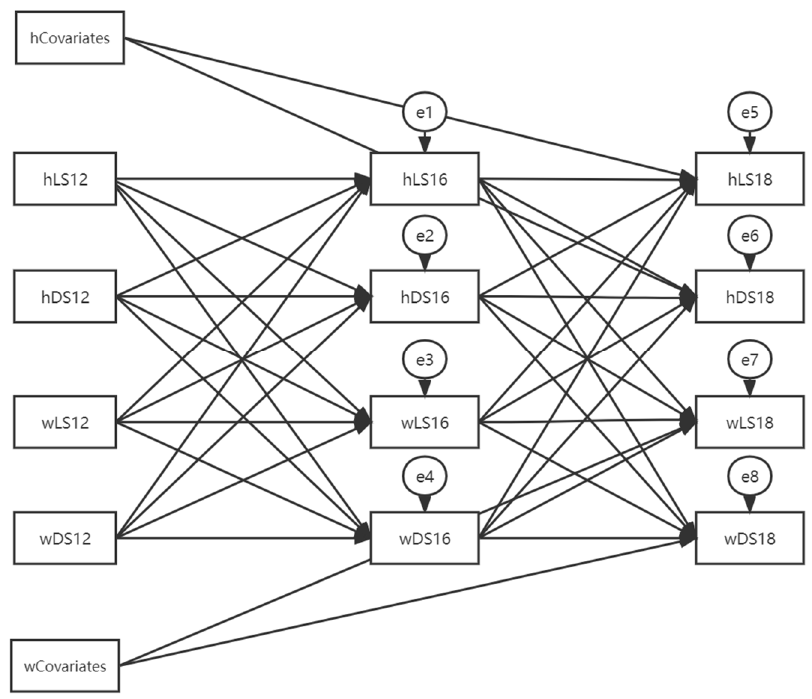
Figure 3. The full APIM model. Note: w, wives’; h, husbands’; MS, marital satisfaction; LS, life satisfaction; DS, depressive symptoms. Covariates include age and income (log-transformed) in 2012 and marital satisfaction in 2014. DS and LS measured in 2012 and the covariates were all set to be covaried. Several pairs of residual errors were set to be intercorrelated: e1 and e3, e2 and e4, e5 and e7, e6 and e8, e1 and e5, e2 and e6, e3 and e7, and e4 and e8. These covariance paths were omitted from the path diagram for the ease of reading.